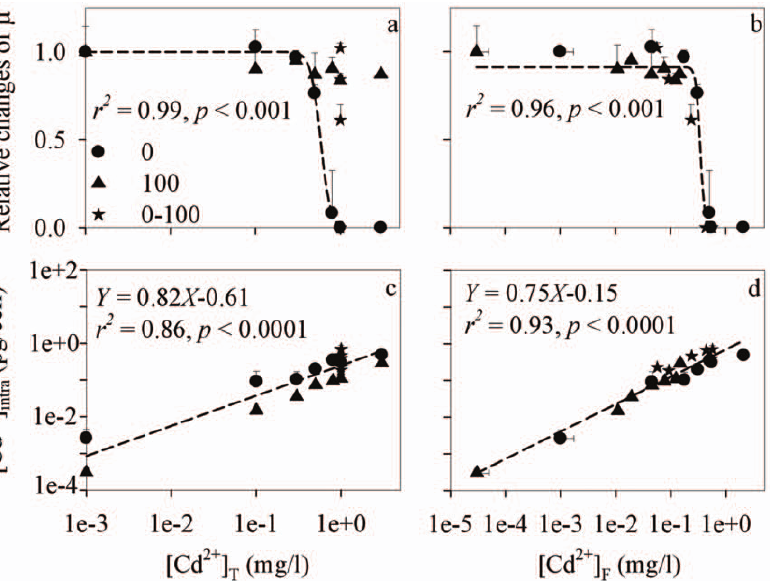
Figure 3. Relative changes of the cell specific growth rate ( m ) (a–b) and intracellular Cd 2 + concentration ([Cd 2 + ] intra , pg/cell) (c–d) with either the total dissolved ([Cd 2 + ] T , mg/l) (a, c) or free Cd 2 + ([Cd 2 + ] F , mg/l) concentrations (b, d) at the beginning of the three toxicity experiments where 0, 100, and 1–100 mg/l TiO 2 -ENs were applied, respectively. Dashed lines represent the simulated curves for the relative changes of m (a–b) and [Cd 2 + ] intra (c–d) at different [Cd 2 + ] T (a, c) and [Cd 2 + ] F (b, d) by the Logistic dose-response and Freundlich models, respectively. Data are mean 6 standard deviation (n=2).